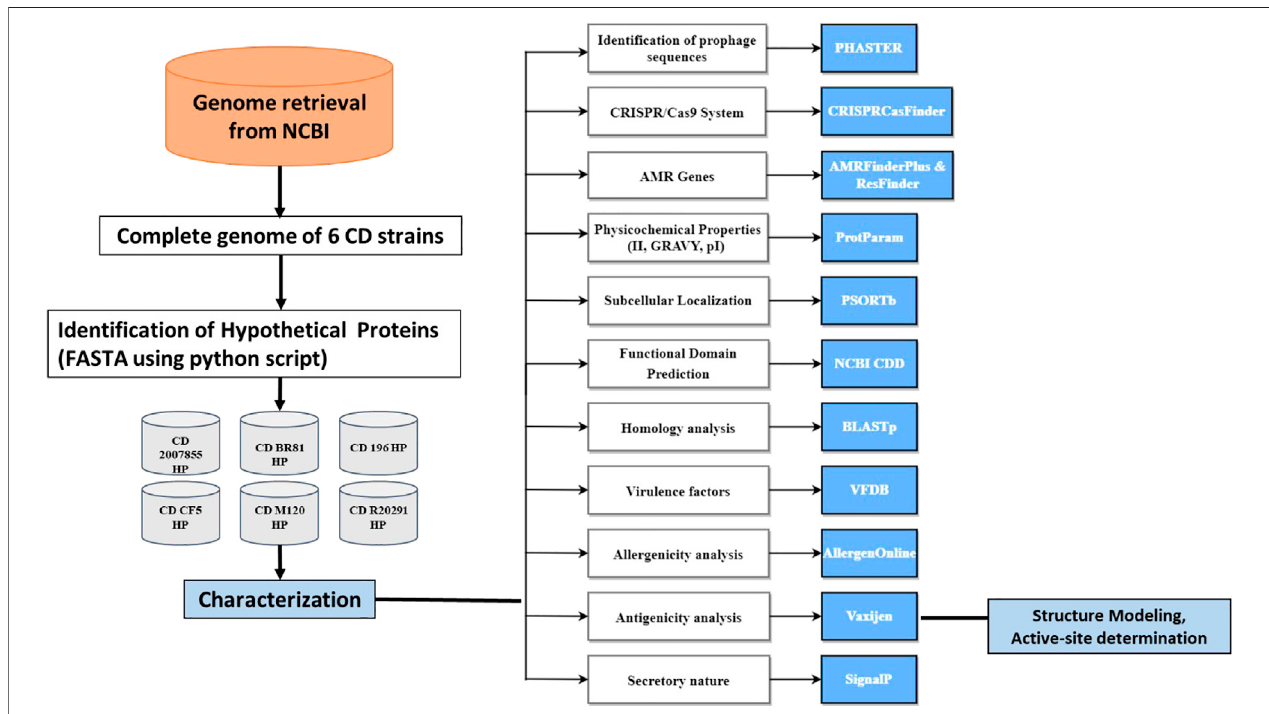
FIGURE 1 | Methodology used for characterization of HPs for Clostridium strains. Brie fl y, we have jotted down the HPs using python script and characterised the six strains of C. dif fi cile using a cohort of tools (Please see methodology). The subsequent annotation is tabulated and analysed.